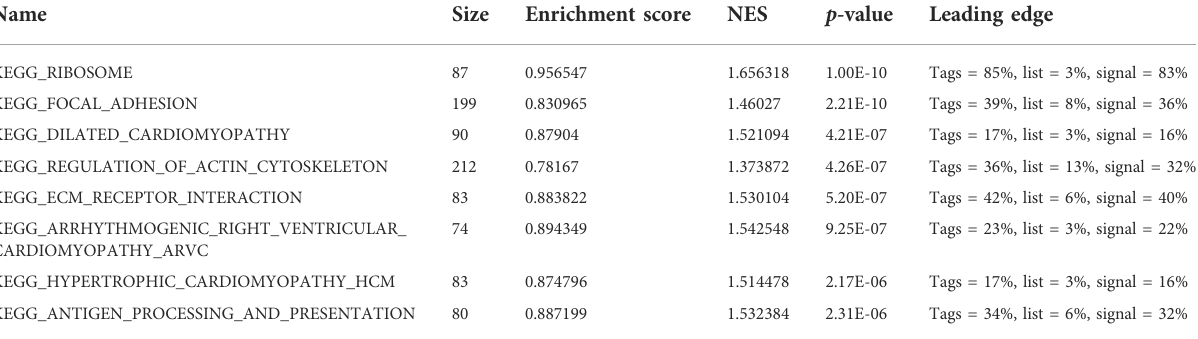
TABLE 6 Results of gene set enrichment analysis